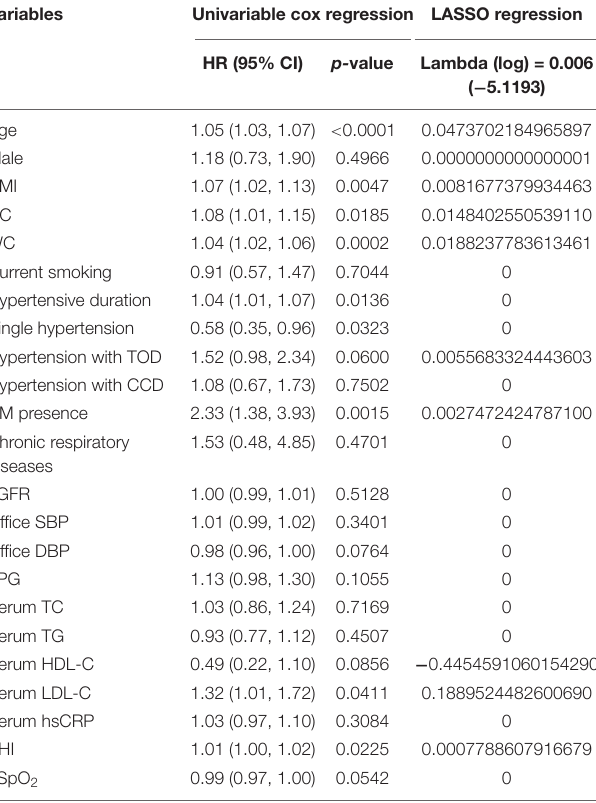
TABLE 2 | Univariable Cox regression analysis and least absolute shrinkage and selection operator (LASSO) regression analysis to extract the potential predictors in the training